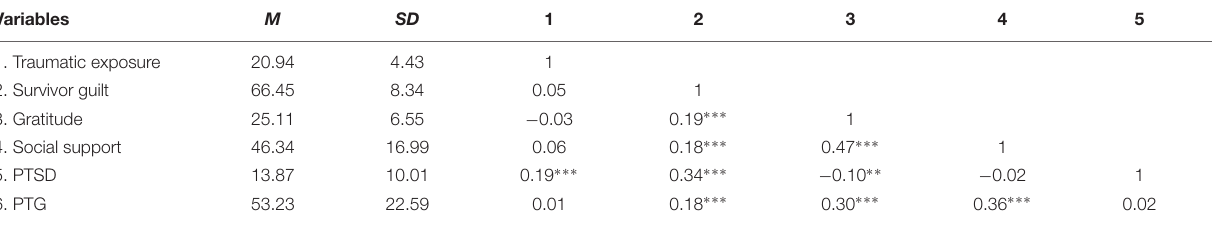
TABLE 1 | Descriptive statistics, and correlations for key variables ( N = 706). Variables